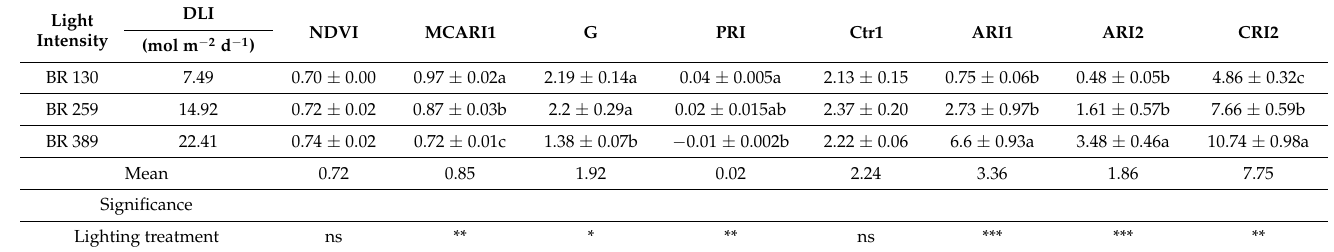
Table 2. Normalized difference vegetation index (NDVI), modified chlorophyll absorption reflectance index 1 (MCARI1), greenness index (G), photochemical reflectance index (PRI), Carter index 1 (Crt1), anthocyanin reflectance index (ARI1, ARI2) and carotenoid reflectance index 2 (CRI2) in Batavia lettuce cv ‘Blackhawk’ grown under three different light intensities (130, 259, 389 µ mol m − 2 s − 1 ). Mean values ± standard errors ( n = 5, 30 DAT). Different letters indicate significative differences at p < 0.5 according to Tukey’s HSD post hoc test. Non-significant or significant differences at p < 0.5, 0.01, and 0.001 are reported as ns or *, **, and ***, respectively.